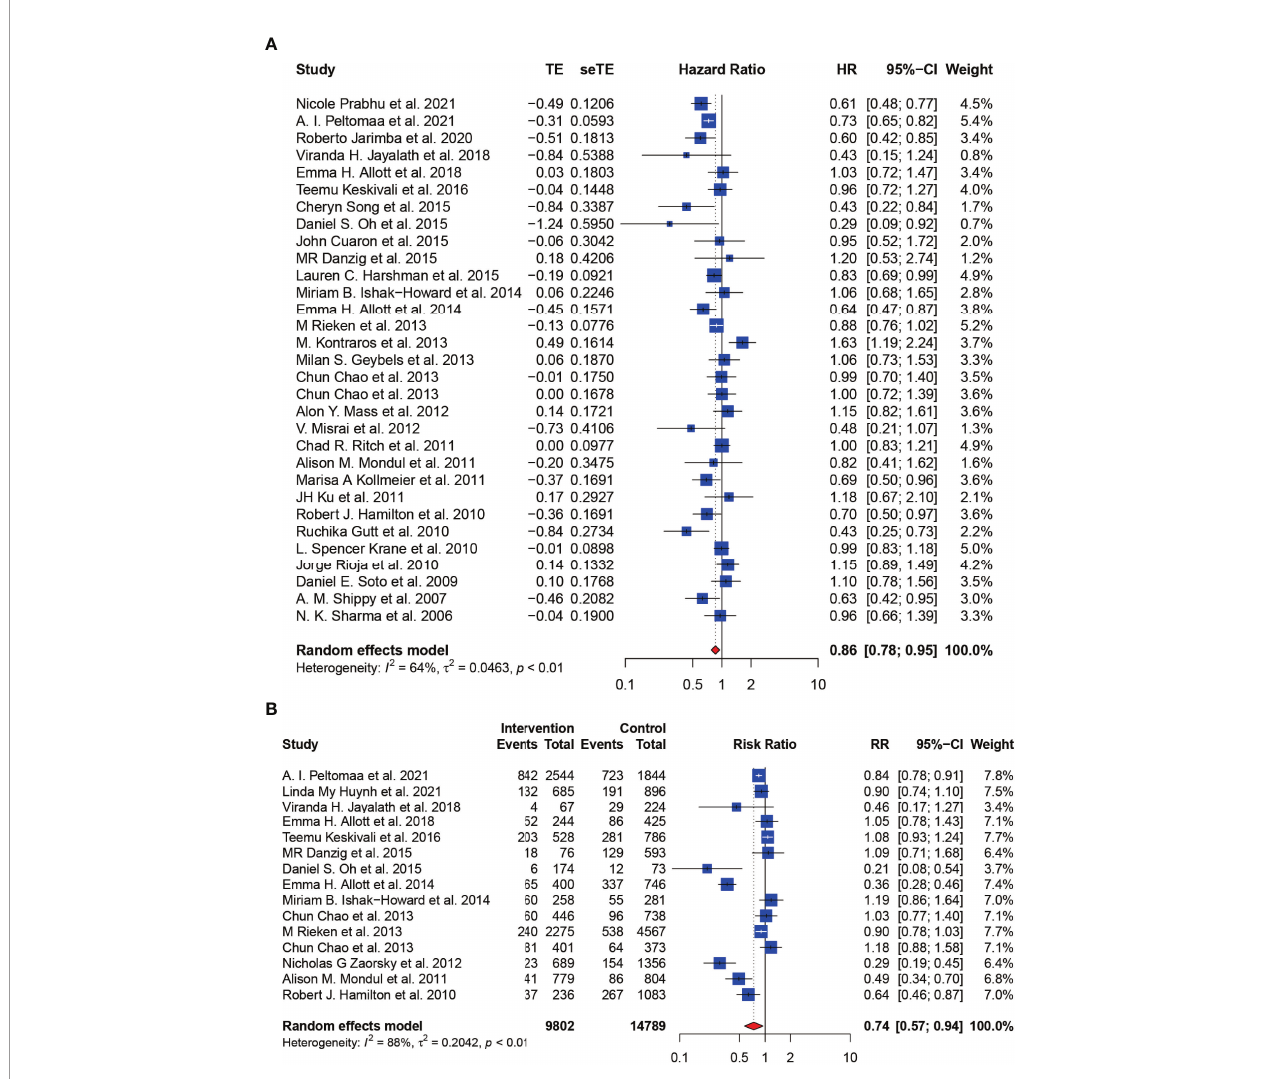
FIGURE 2 | The effect of statins on BCR risk of prostate cancer among men following de fi nitive therapy using the random effects model. (A) Forest plot for the HR of BCR. (B) Forest plot for the RR of